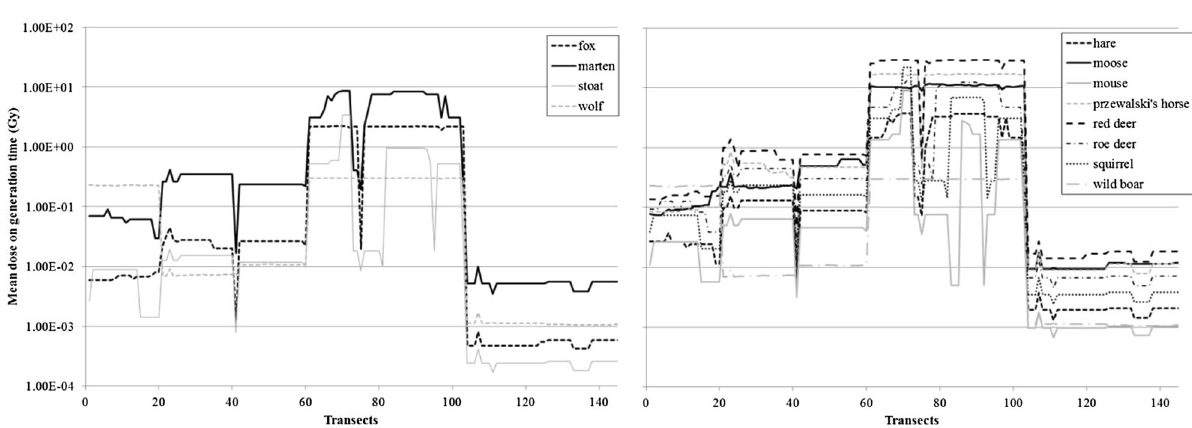
Figure 3. Total dose absorbed over generation time by mammal species as a function of the transect, calculated using the mean activity concentrations of 137 Cs and 90 Sr in soil (left: predators; right: